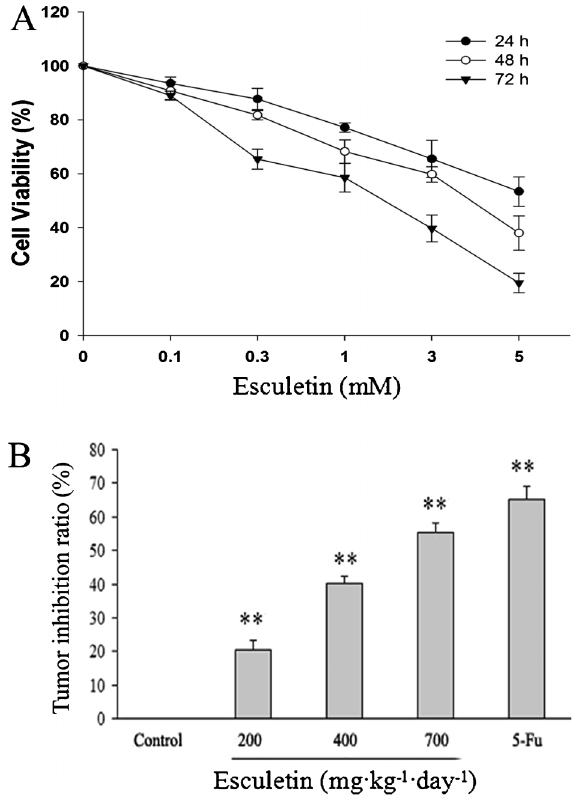
Figure 1. Effect of esculetin on the growth of hepatocellular carcinoma in vivo and in vitro . SMC7721 cells were seeded onto 96-well plates, and then treated with different concentrations of esculetin for 24, 48, and 72 h. Cell viability was determined by MTT assay ( A ). Hepa1-6 cells were inoculated subcutaneously at the right axilla of C57BL/6J mice (1 6 10 7 viable cells/mL) to establish the xenograft model. Tumor inhibition ( B ) is reported as a ratio: tumor inhibition (%) = (1-W Treated ) / W Control 6 100%. W Treated and W Control are the average tumor weights in treated and control mice, respectively. Data are reported as means±SD for n=15. **P , 0.01 vs control group (one-way ANOVA followed by Bonferroni’s